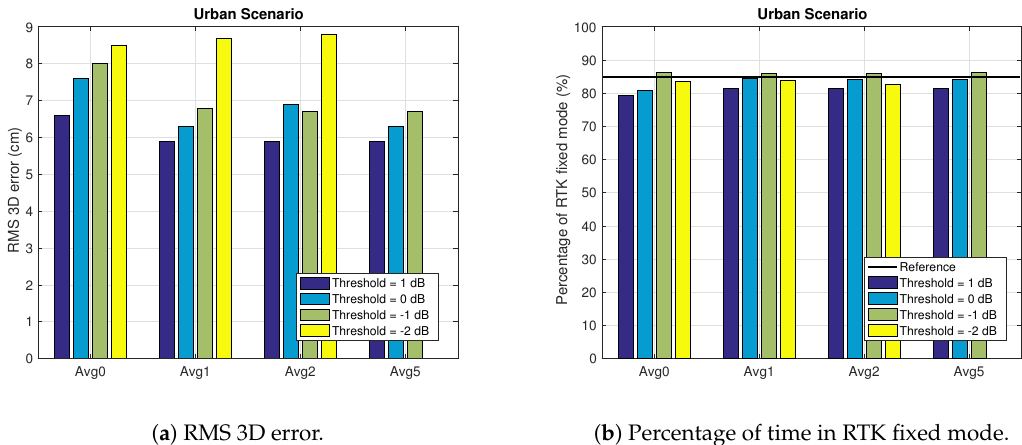
Figure 13. Results in the Urban scenario for different exclusion thresholds and average configurations. The reference value is omitted in ( a ) due to the large difference with the values illustrated in the